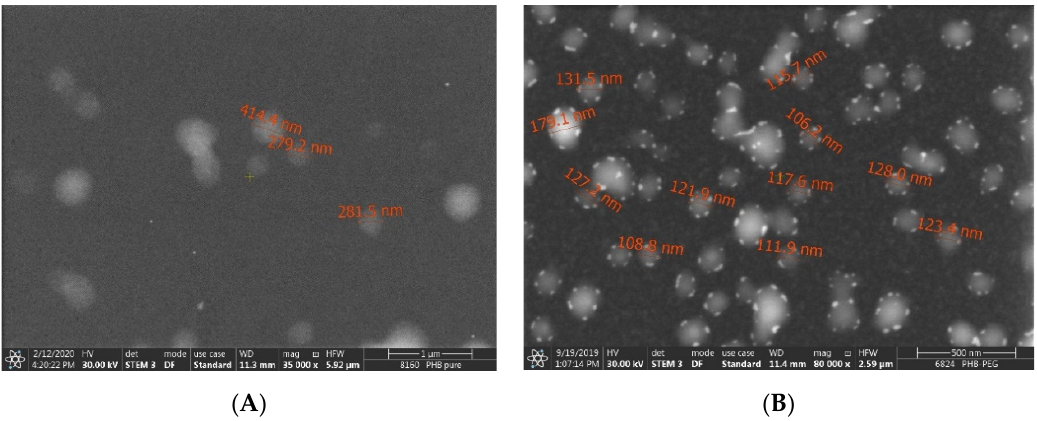
Figure 1. Scanning electronmicroscopic images of the PHB ( A ) and PEGylated PHB ( B ) nanoparticles.